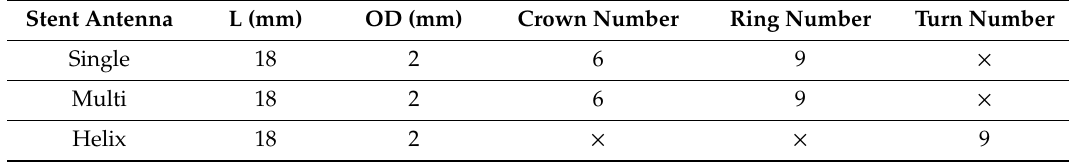
Table 1. The geometric parameters of three stent antennas.